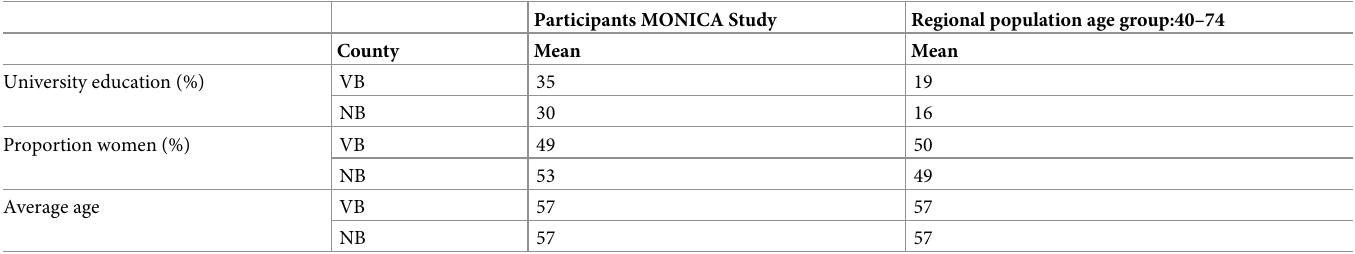
Table 1. Sample characteristics in comparison with the regional